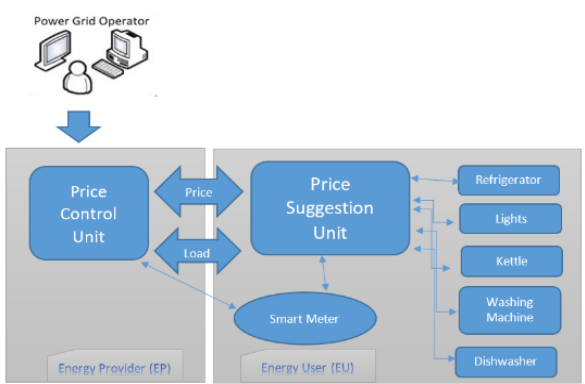
Figure 1. The architectural diagram of the